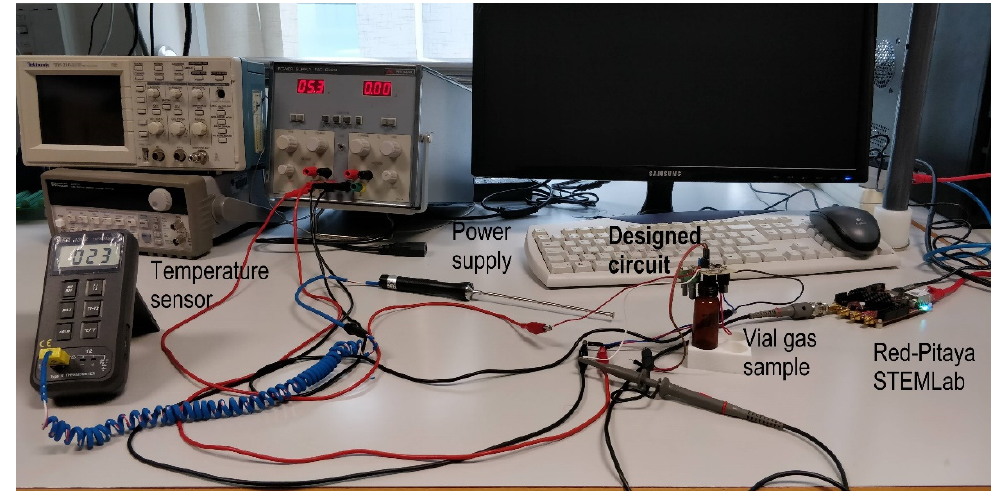
Figure 8. Experimental setup including the Red-Pitaya, the designed circuit with the vial including the gas sampling.